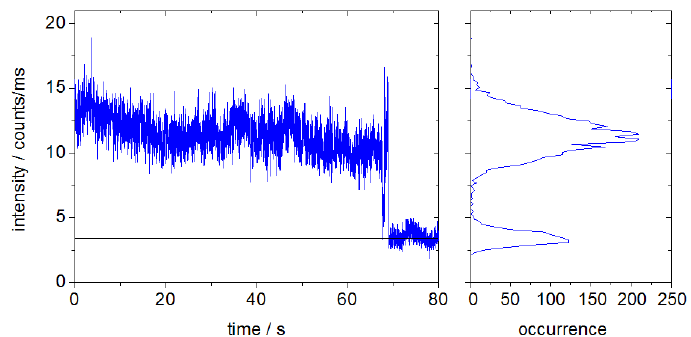
Figure 5. An example of a single molecule fluorescence trajectory with intensity histogram recorded at 21°C. The black horizontal line shows the background level.